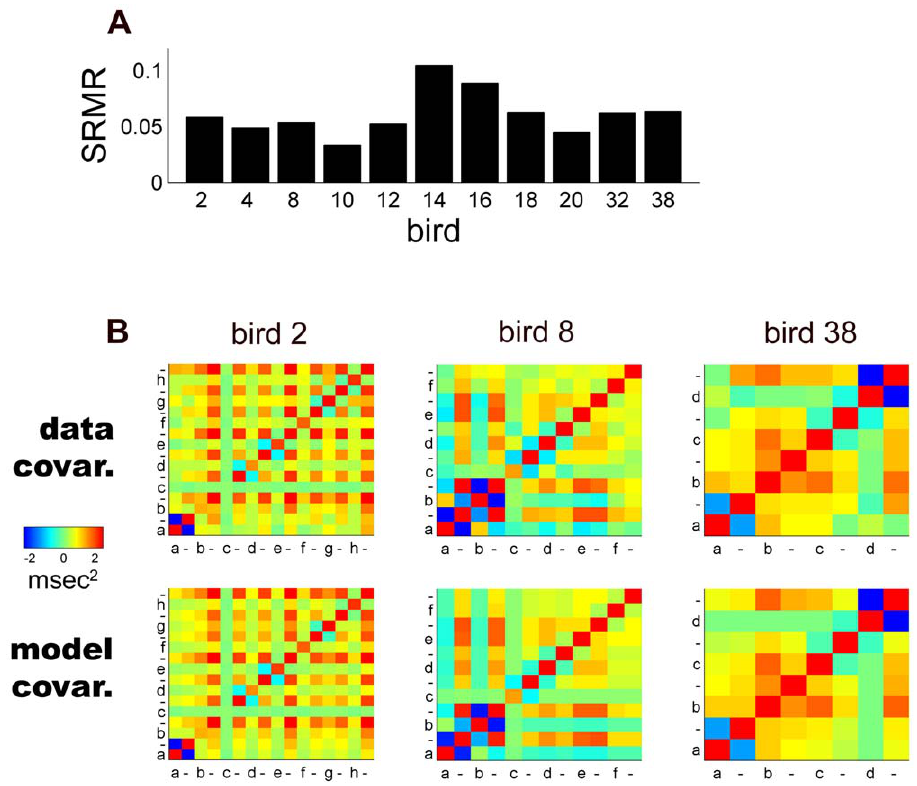
Figure 2. Goodness of fit between the timing model and data from 11 zebra finch birds. A, SRMR by bird (see Results). B, Color plots of the timing covariance matrices from the data and model for 3 representative birds.